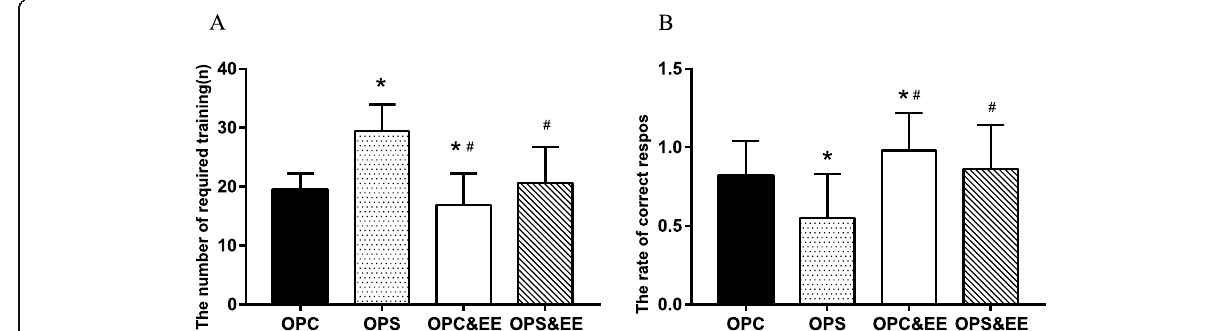
Fig. 6 The comparison among OPC, OPS, OPC&EE, and OPS&EE in learning and memory of Y-maze. Differences in the number of required training and the rate of correct response in Y-maze were detected among OPC, OPS, OPC&EE, and OPS&EE. The number of required training and the rate of correct response were improved by enriched environment in the OPS. Data were respectively analyzed using One-way ANOVA, followed by LSD-t test to make comparison at the two different groups. Number of animals in each offspring group = 16 (50% male, 50% female). ( a The number of required training of the offspring in Y-maze. b The rate of correct response of the offspring in Y-maze. * P < 0.05 vs. OPC. # P < 0.05 vs. OPS)